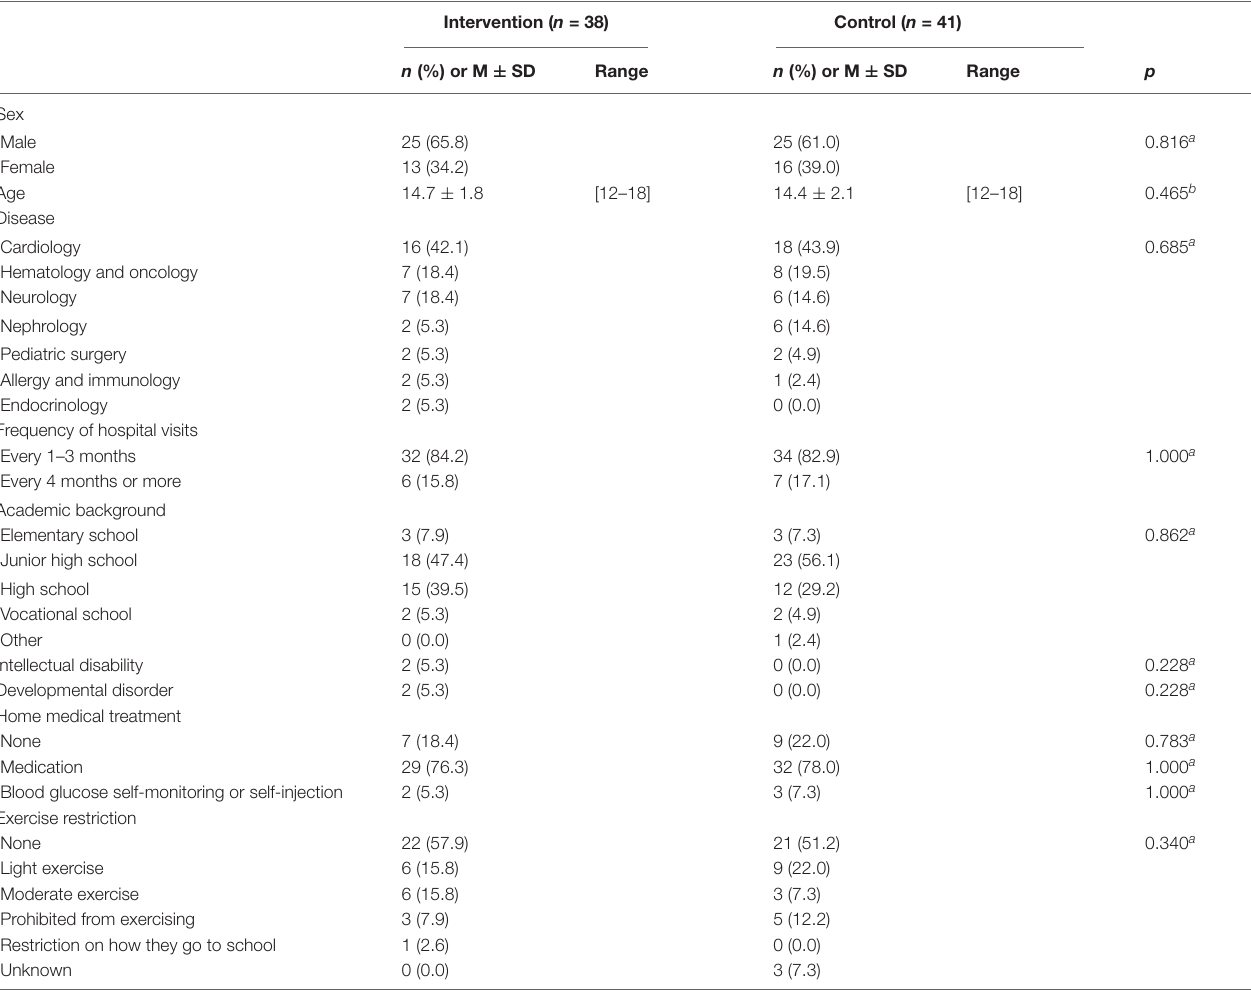
TABLE 1 | Participants’ characteristics.